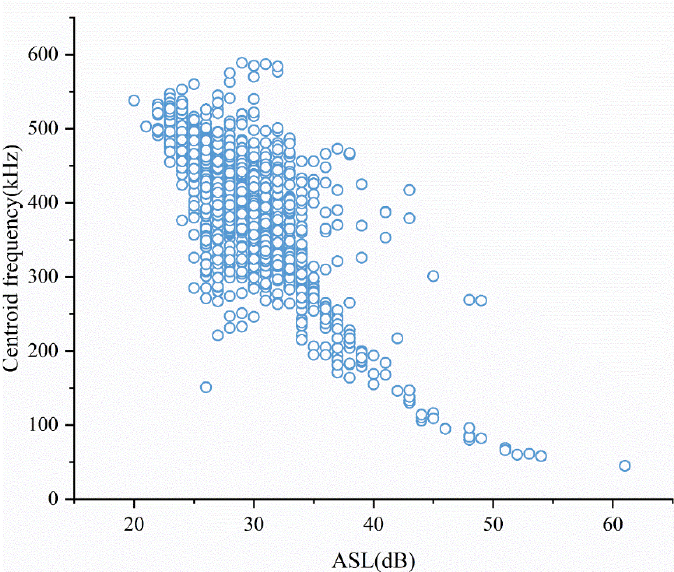
Figure 26. ASL-centroid frequency correlation diagram of Yellow River Bridge.